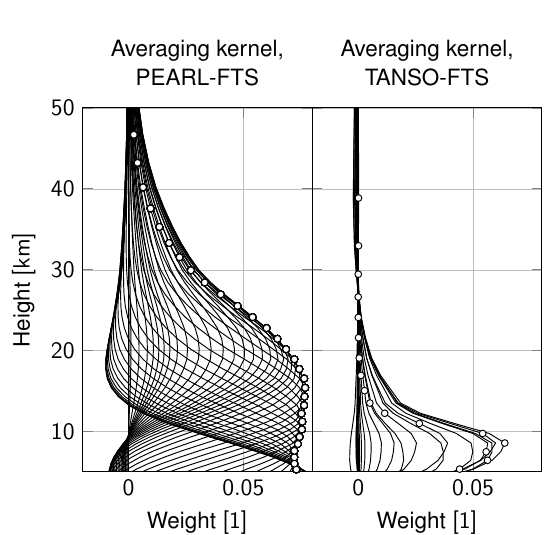
Figure 2. Arithmetic mean of all averaging kernels for the set of collocations between PEARL-FTS and TANSO-FTS. The left panel shows averaging kernels for PEARL-FTS and the right panel shows averaging kernels for TANSO-FTS. The white circles with a black edge indicate the nominal altitude for each retrieval